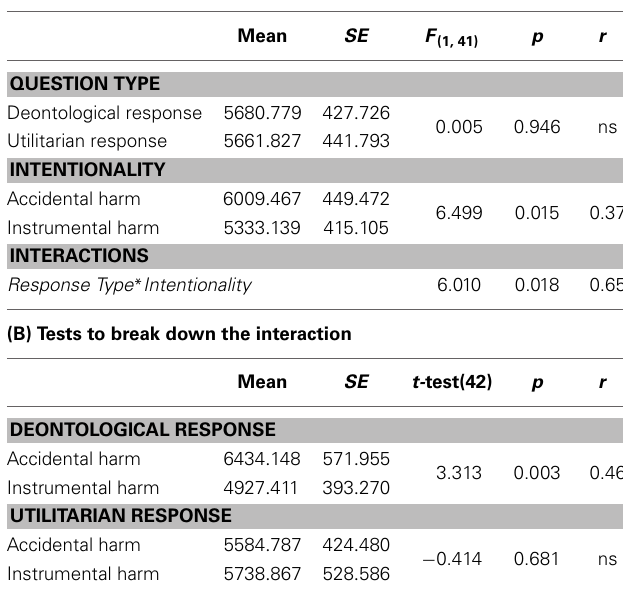
Table 8 | Main Effects and Interactions of the RM ANOVA Question Type * Intentionality